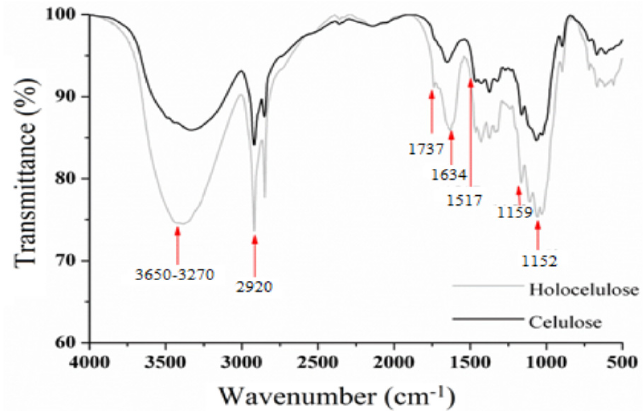
Figure 6. Fourier transform infrared (FT-IR) spectra of holocellulose and cellulose.